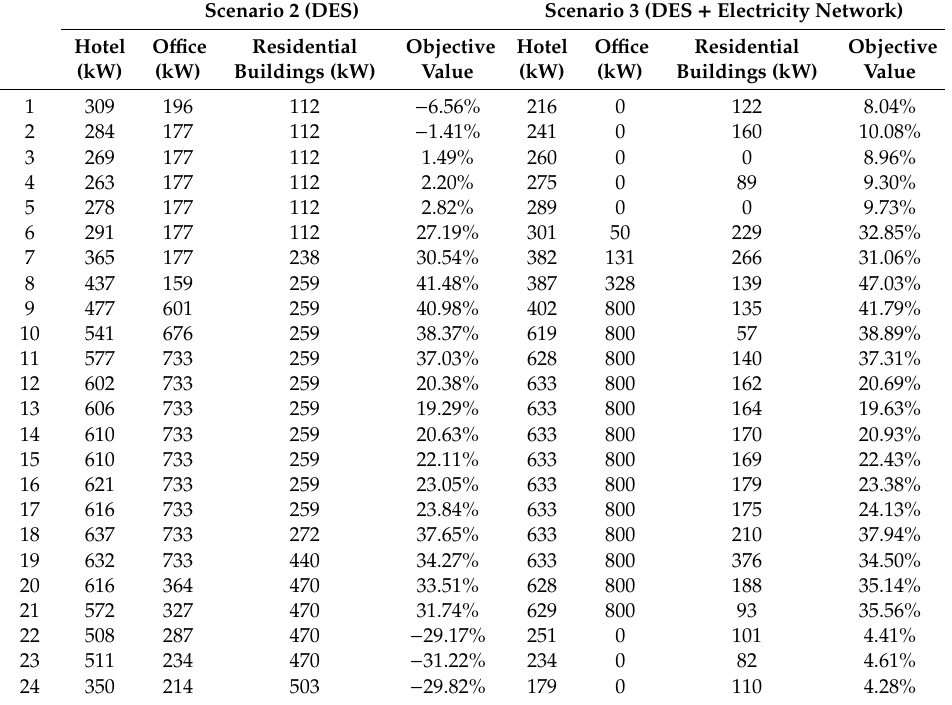
Table 9. The results of optimal system design of hourly energy demand in typical mid-season